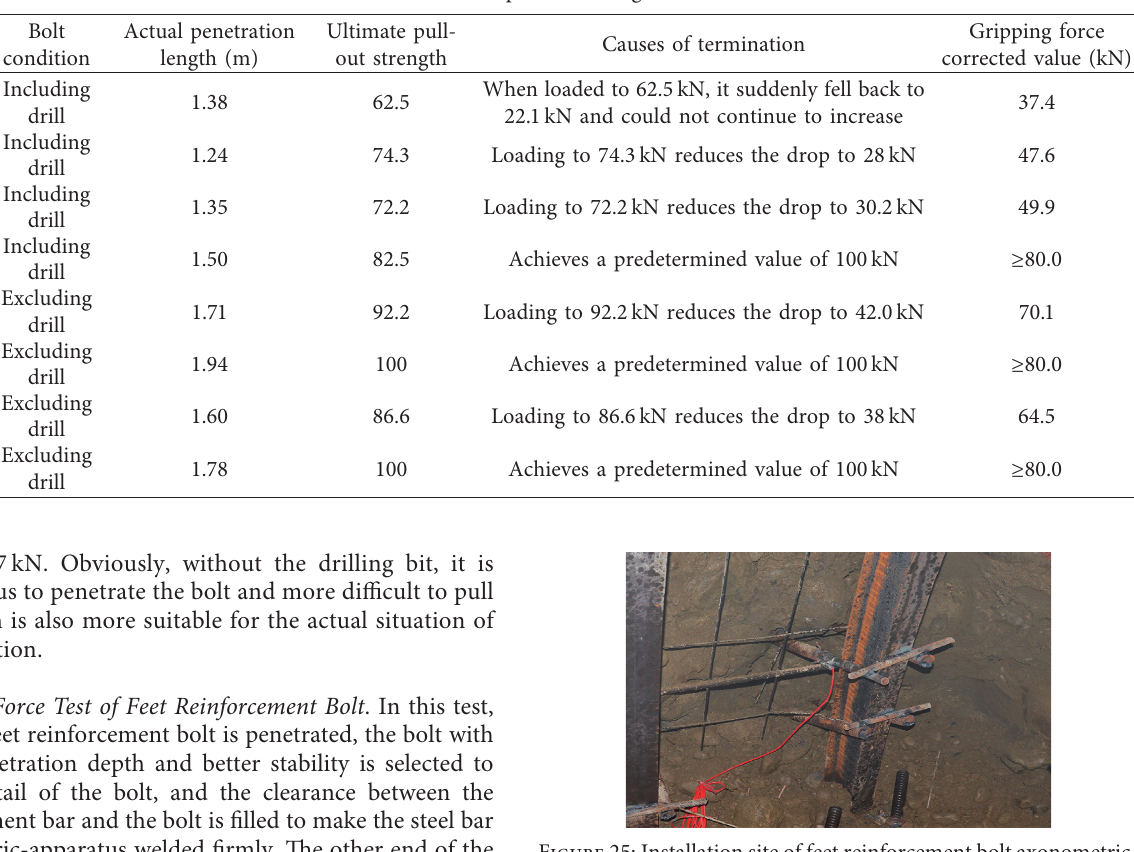
Figure 24: The end of the 51 mm-in-diameter bolt is above the floated Table 1: ∅ 25 ultimate pull-out strength of bolts.